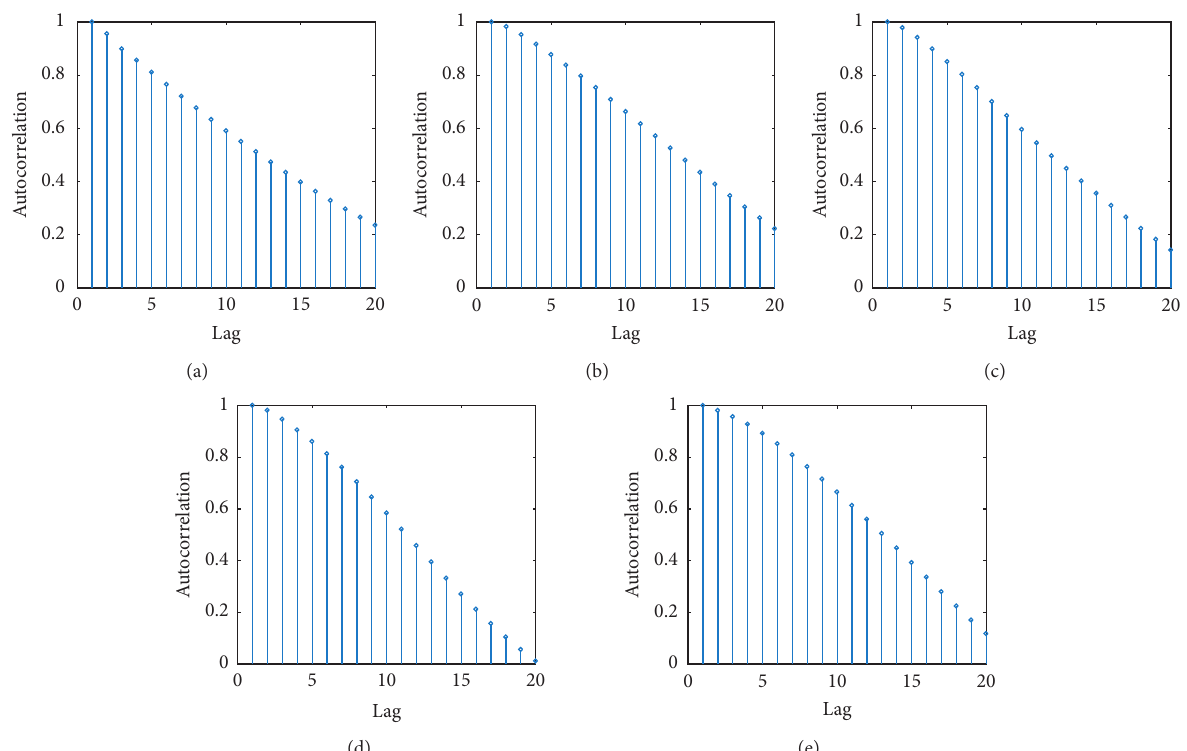
Figure 3: Autocorrelation functions of 5-minute travel time on links A, B, C, D, and E. (a) Link A. (b) Link B. (c) Link C. (d) Link D. (e) Link E.